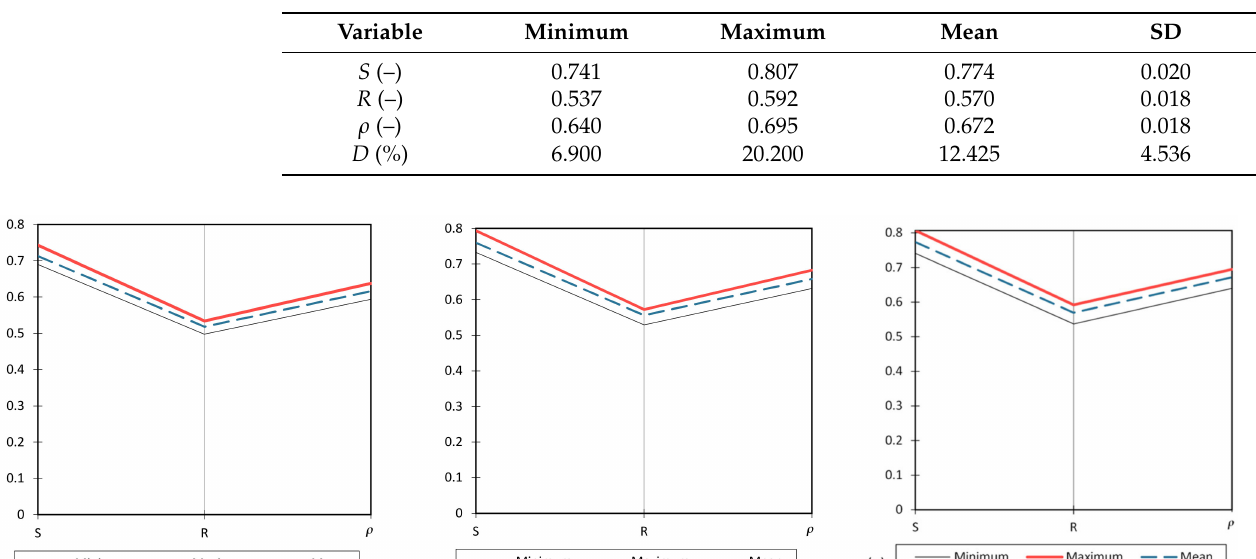
Table 3. Shape descriptors and damping ratio after 120 cyclic tests.